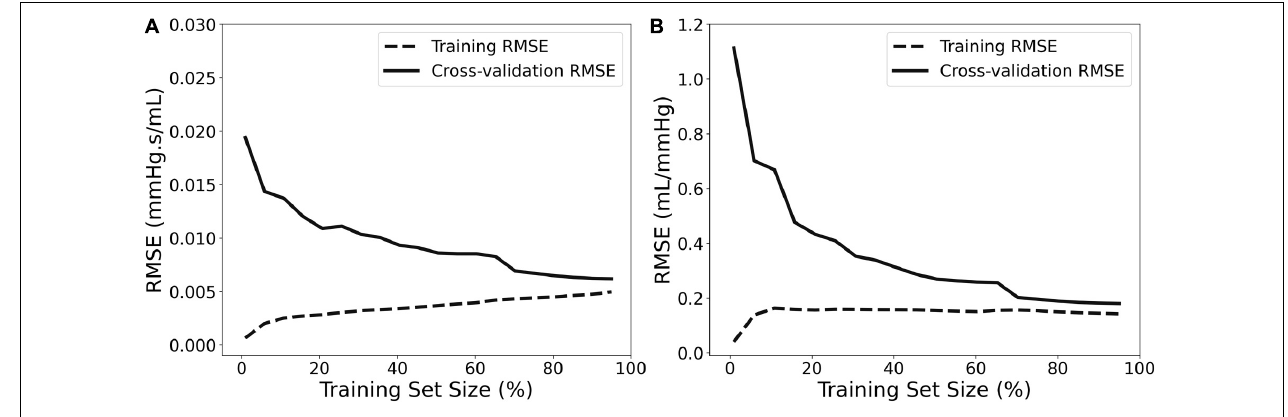
FIGURE 5 | Learning curves presenting the impact of the number of data instances on the RFR’s performance for Z ao (A) and C T (B) .